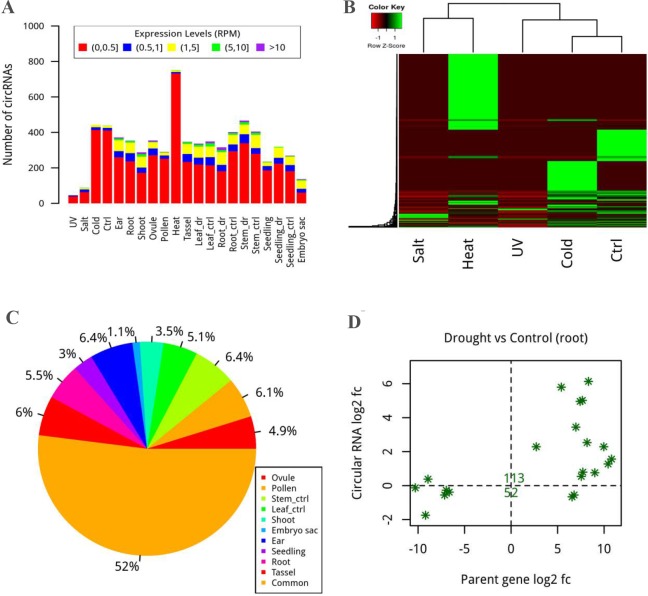
Expression pattern of circRNAs.(A) Expression level of circRNAs in different scopes. CircRNAs were usually expressed at lower levels, which may explain their difficult detection because they lack a poly(A) tail. ctrl and dr indicate control and drought, respectively. (B) The degree of circRNA expression under five different treatments was shown by heatmap. More circRNAs were present under heat stress. (C) Pie chart with rainbow colours showing the ratio of circRNAs possessing tissue-specific expression in 10 different tissues. (D) Tendency for differential expression of circRNAs and the overlapping genes was plotted using fold changes between the drought and control in root as the standard. The number of both differentially expression circRNAs and genes is marked.